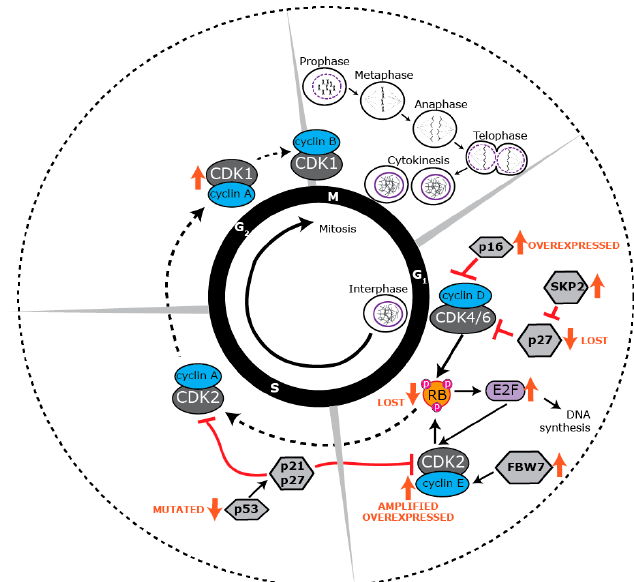
Figure 2. Dysregulation of the cell cycle machinery in BLBC. Schematic view of the cell cycle. Each phase of the cell cycle is regulated by cyclin-dependent kinases (CDKs), their regulatory protein partners (cyclins) and CDK inhibitors. Many proteins in the G 1 /S phase transition of the cell cycle are specifically dysregulated in BLBC. Orange upward arrows indicate an increase in expression; orange downward arrows indicate a decrease in expression.